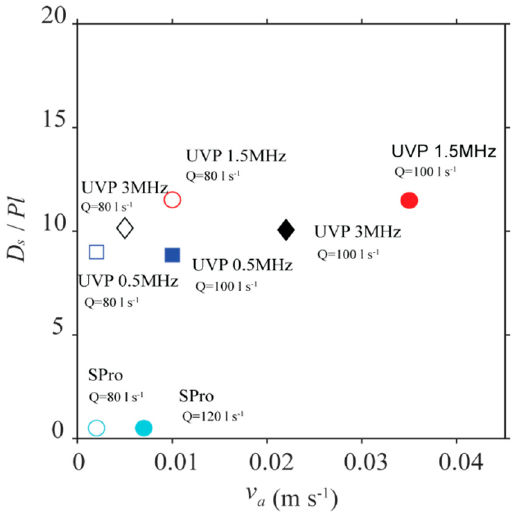
Figure 8. The influence of the monostatic acoustic geometry and sampling in the bedload measurements.